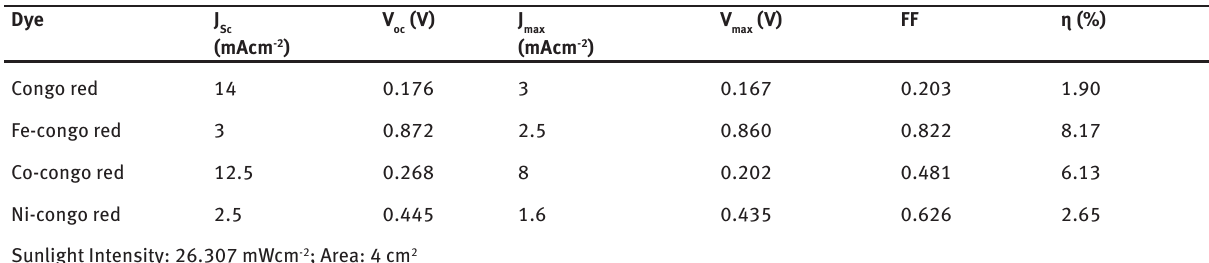
Table 6: The effective nuclear charge (Z Metal